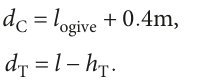
Table 2: Auxiliary mass m